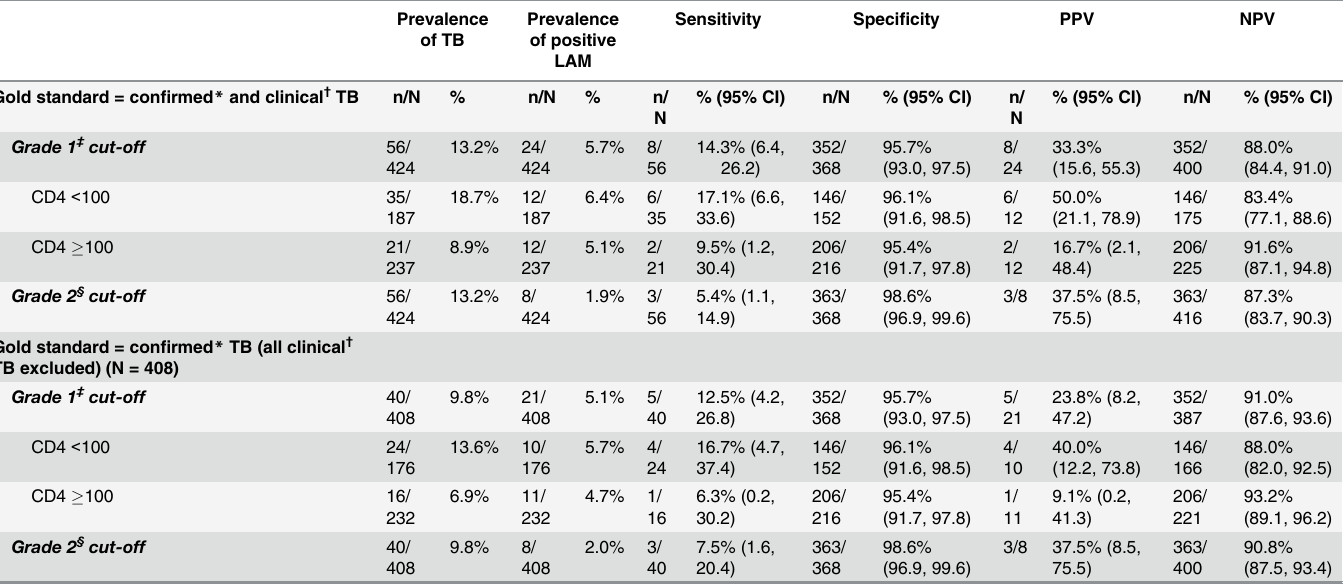
Table 2. Diagnostic accuracy of LF-LAM among HIV clinic attendees with CD4 < 200.